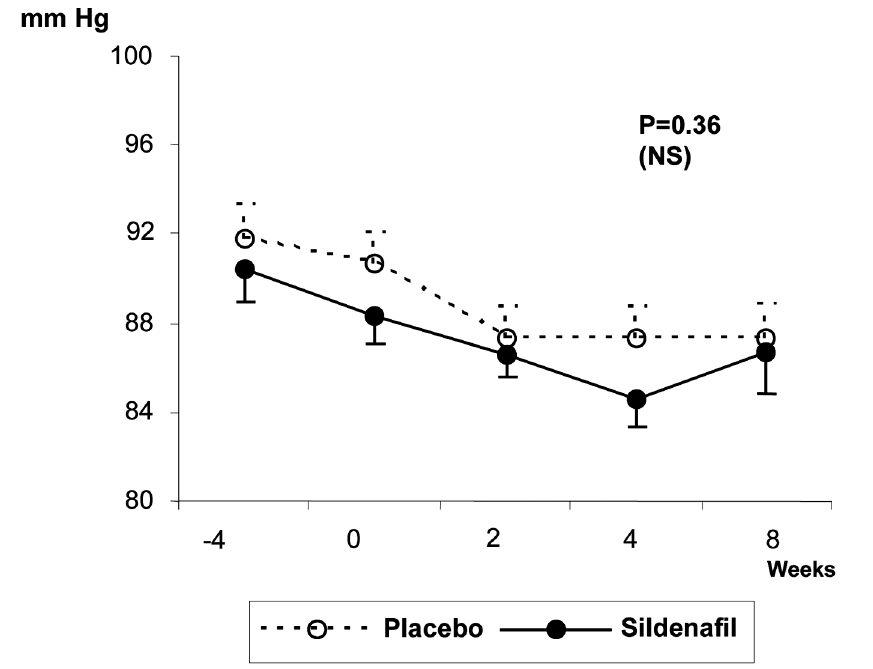
Figure 4 – Blood pressure (BP) behavior during the study. Diastolic BP in the supine position. P values refer to the comparisons between sildenafil and placebo. NS = not significant.